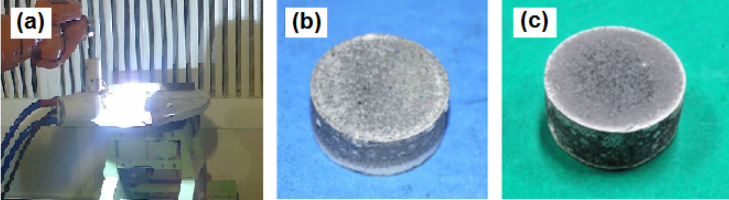
Fig. 6 (a) Sintered sample of 30 mm in diameter being exposed to plasma flame at 2700 ℃ . Appearance of samples after 10 min exposure: (b) PLS ZrB 2 –SiC–B 4 C composite, weight gain +11.67 mg/cm 2 and (c) PLRS 2.0 composite, weight gain +12.75 mg/cm 2